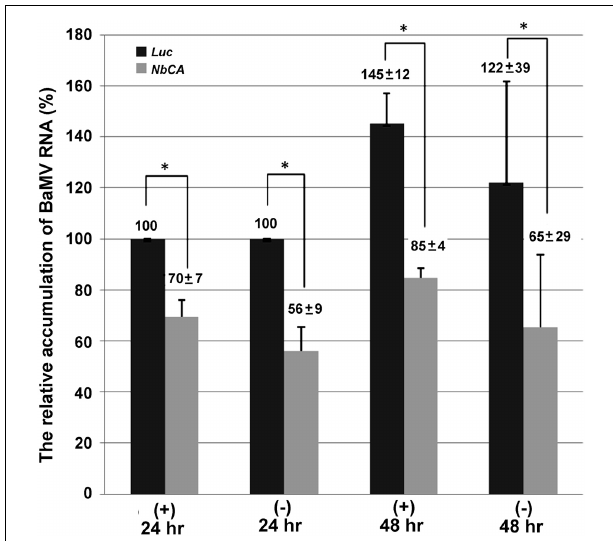
FIGURE 3 | The relative accumulation of BaMV plus- and minus-strand RNA in NbCA -knockdown protoplasts. Real-time RT-PCR was used to quantify the accumulation of BaMV plus- and minus-strand RNA in Luc - and NbCA -knockdown N. benthamiana protoplasts at 24 and 48 hpi. The accumulation of BaMV RNA detected from Luc -knockdown protoplasts at 24 hpi was set to 100%. The numbers are the average accumulation of BaMV plus- and minus-strand RNA with the standard error obtained from three independent experiments; ∗ p < 0.05 by Student’s t